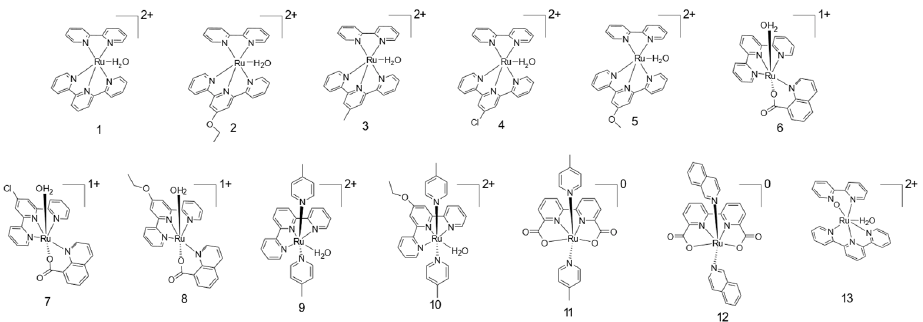
Figure 1. A schematic representation of the complexes considered in this study. ( 1 ) Ru(tpy)(bpy) ( 2 ) Ru(tpyEtO)(bpy) ( 3 ) Ru(tpyMe)(bpy) ( 4 ) Ru(tpy − Cl)(bpy) ( 5 ) Ru(tpyMeO)(bpy) ( 6 ) trans − Ru(tpy)(QC) ( 7 ) trans − Ru(tpy − Cl)(QC) ( 8 ) trans − Ru(EtOtpy)(QC) ( 9 ) Ru(tpy)(4 − pic) 2 ( 10 ) Ru(EtOtpy)(4 − pic) 2 ( 11 ) Ru(bda)(4 − pic) 2 ( 12 ) Ru(bda)(isoq) 2 ( 13 ) Ru(tpy)(bpyNO). The OER process occurs via a series of redox steps involving various reaction inter ‐ mediates. The metal center coordinates water and is successively oxidized. Later, an O − O bond is formed, and molecular oxygen is ultimately released. Two primary paths lead to O − O bonds: water nucleophilic attack (WNA) and the interaction of two metal − oxo